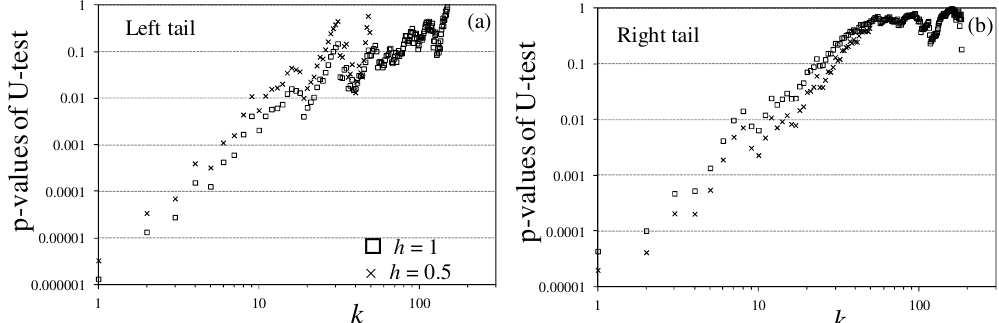
Fig. 15. U test p values for (a) left and (b) right tails of increments along x direction on the Berea sandstone block at s = 10 1 .